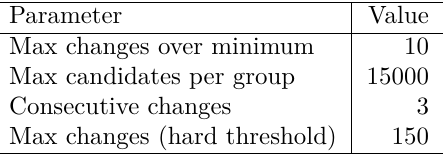
Table 2: Parameters for error correction